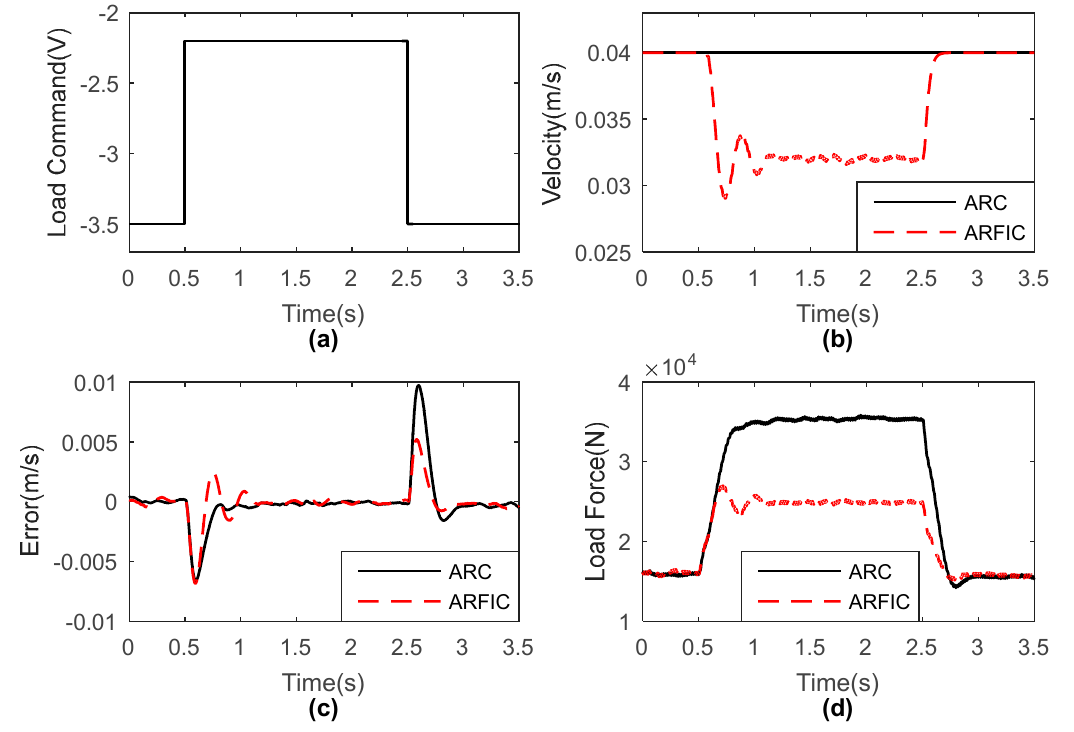
Figure 12. Tracking performance with a 0.04 m/s velocity command and − 3.5 V ∼ − 2.2 V ∼ − 3.5